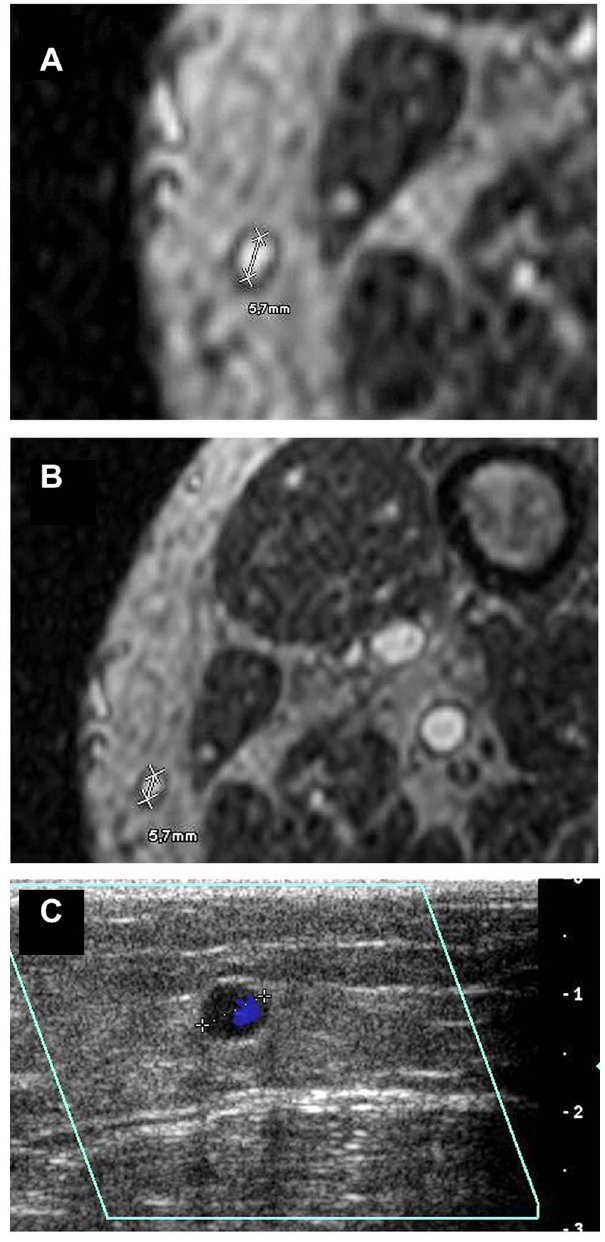
Figure 3. MR-angiographic and duplex sonographic images of the great saphenous vein. Magnetic resonance imaging (BPCA-MRA) and color-coded duplex sonography in the proximal level of the left GSV of a 63 year old female patient who suffered from PAOD stage III and was referred to the radiological department for assessment of the arterial status prior to a proposed bypass surgery. (a, b) Axial multiplanar reformat of contrast-enhanced T1-weighted gradient-echo images during the steady-state. (c) Axial color-coded duplex sonogra- phy. doi:10.1371/journal.pone.0112340.g003 integrated body coil served for image acquisition of the upper legs and pelvic region. Using a biphasic injection protocol, Gadofos- veset trisodium was administered with an automatic power injector (Spectris; Medrad Europe, Beek, the Netherlands) at a flow rate of 1.2 ml/sec followed by a 25 ml saline flush at a flow rate of 0.6 ml/sec. As soon as the contrast medium was detected at the